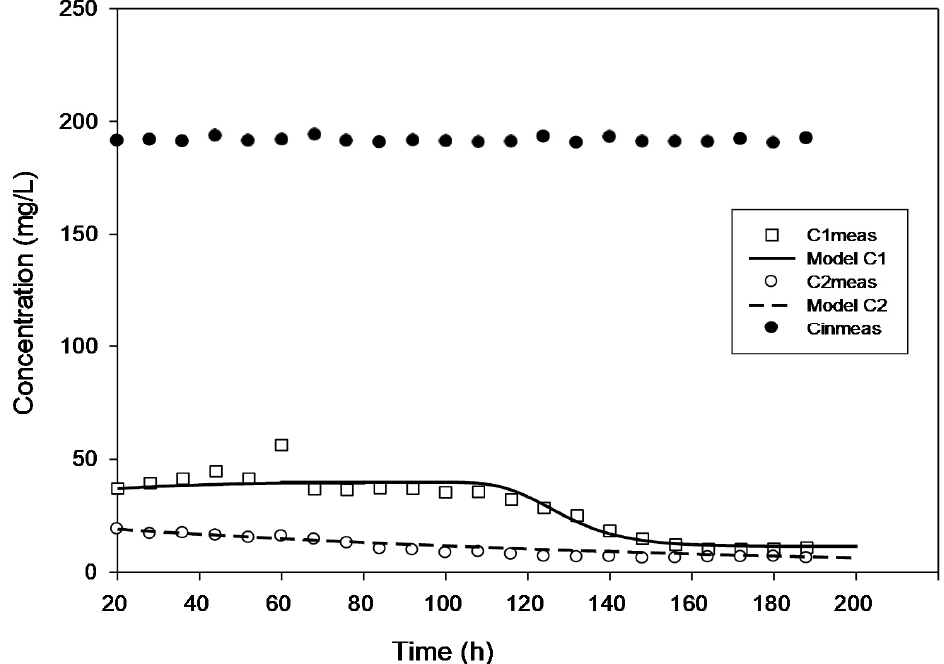
Figure 5. Model validation for the concentration of 200 mg·L − 1 with added H 2 O 2. Table 4. Kinetic parameter estimation for the biological reactor at different initial concentrations using AQUASIM (Haldane model).